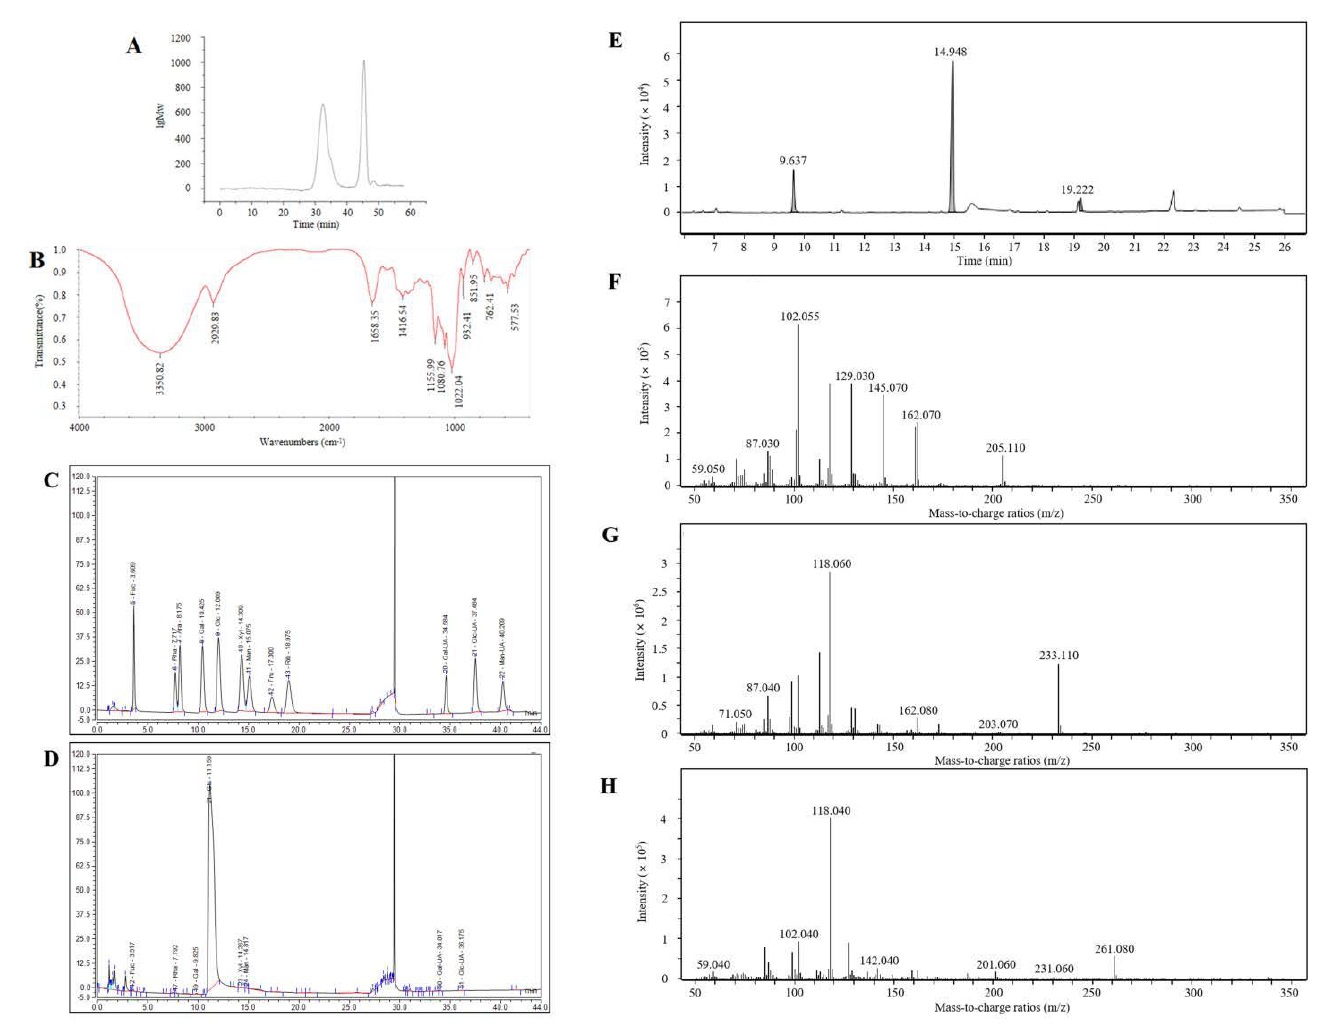
Figure 4. HPGPC chromatogram ( A ) and FT-IR spectrum ( B ) of PAP-1. Chromatogram of standard ( C ) and PAP-1 ( D ).The spectrum of PAP-1 by methylation analysis: ( E ) Spectrum of total ion flow of PAP-1; ( F ) Spectrum of t-Glc(p); ( G ) Spectrum of 4-Glc(p); ( H ) Spectrum of 4,6-Glc(p).